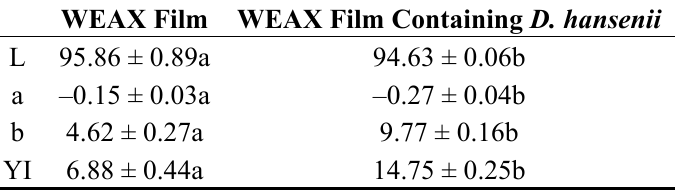
Table 2. Color values (L, a, and b), and yellowness index (YI) of WEAX film and WEAX film containing D. hansenii .